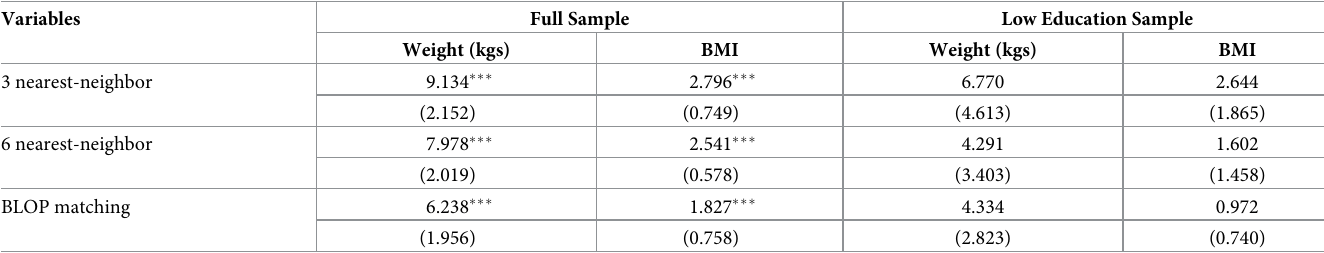
Table 5. Average treatment effect using alternative specifications.